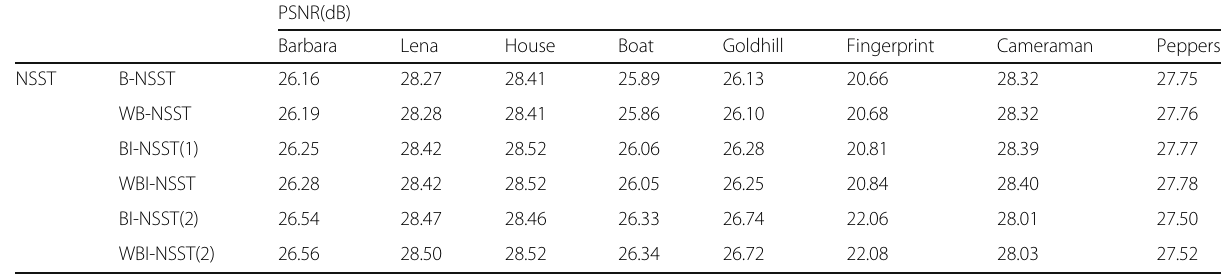
¼ 0 : 1. The algorithm was run 30 times for n